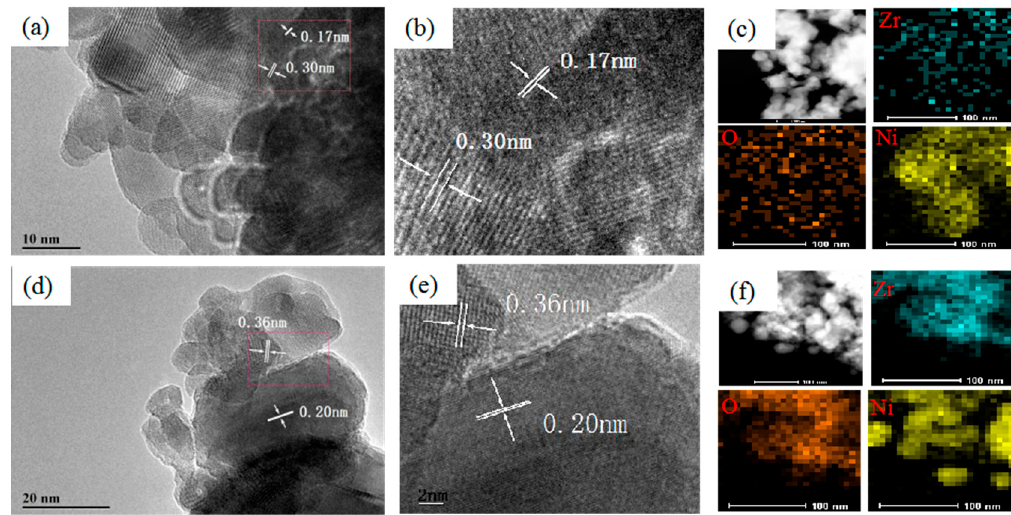
Figure 4. High-resolution transmission electron microscopy (HRTEM) images of ( a ) Ni/ZrO 2 (P) and ( d ) Ni/ZrO 2 (H). Enlarged selected area HRTEM images of ( b ) Ni/ZrO 2 (P) and ( e ) Ni/ZrO 2 (H). HAADF-STEM images and corresponding EDS elemental mapping images of ( c ) Ni/ZrO 2 (P) and ( f ) Ni/ZrO 2 (H).